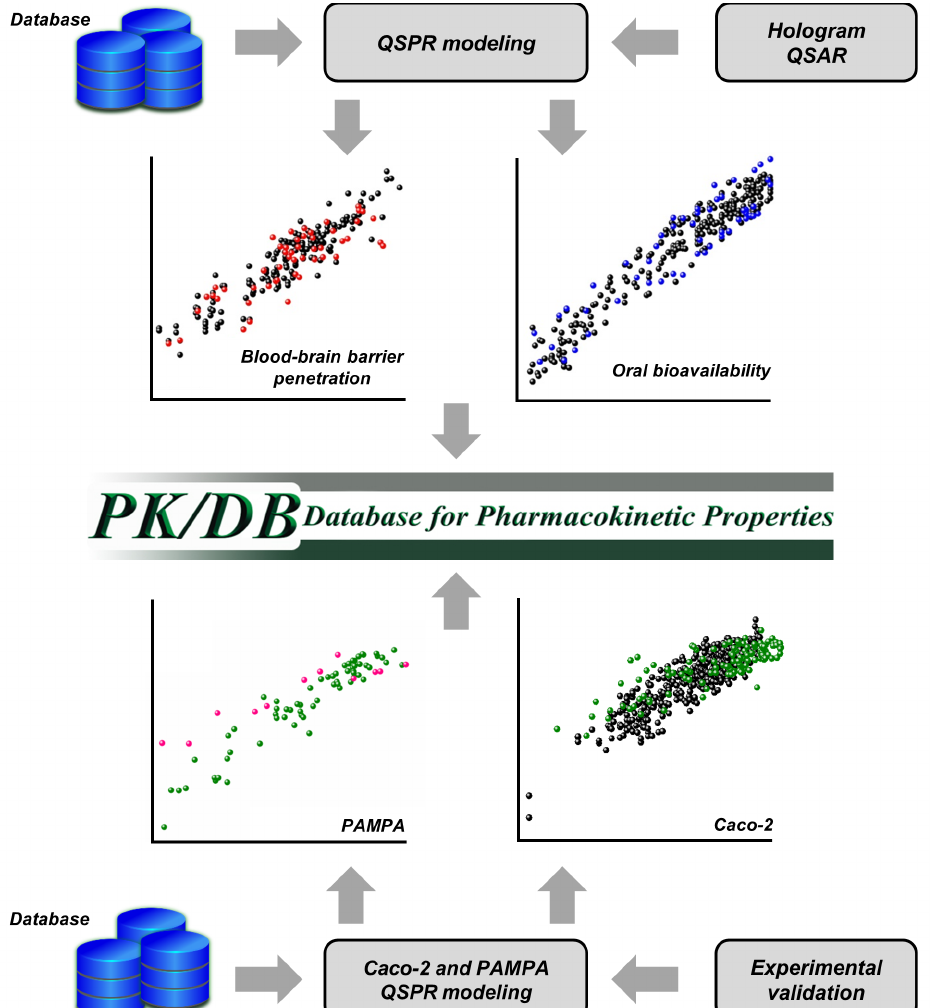
Figure 5 - Quantitative structure-property relationship (QSPR) modeling and the construction of the Database for Pharmacokinetic Properties